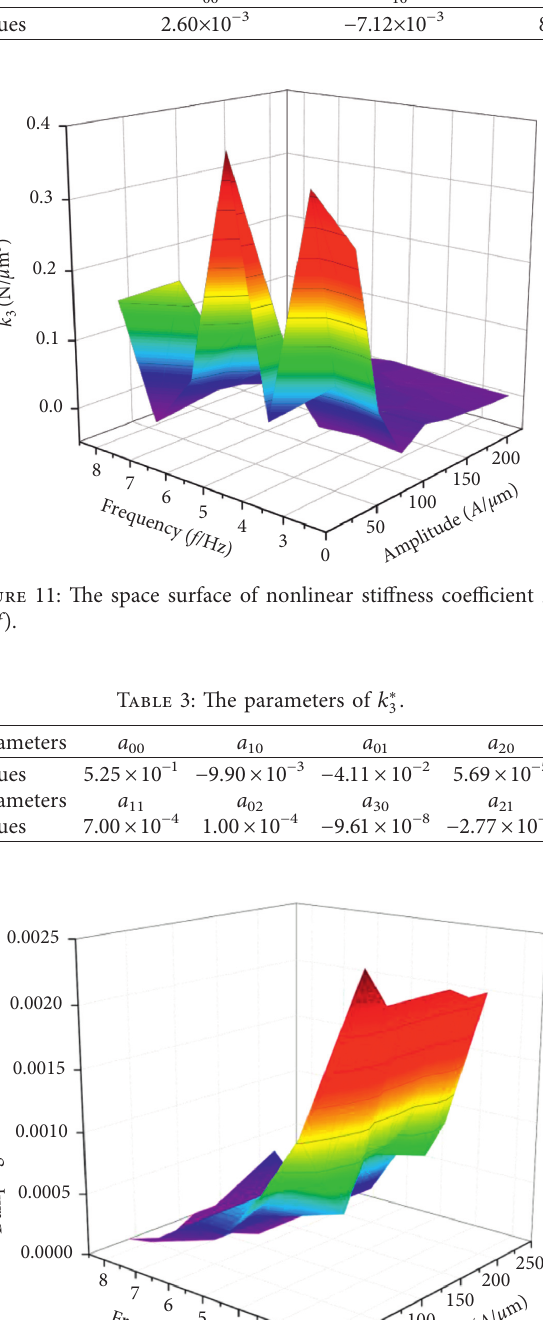
Table 2: The parameters of k ∗